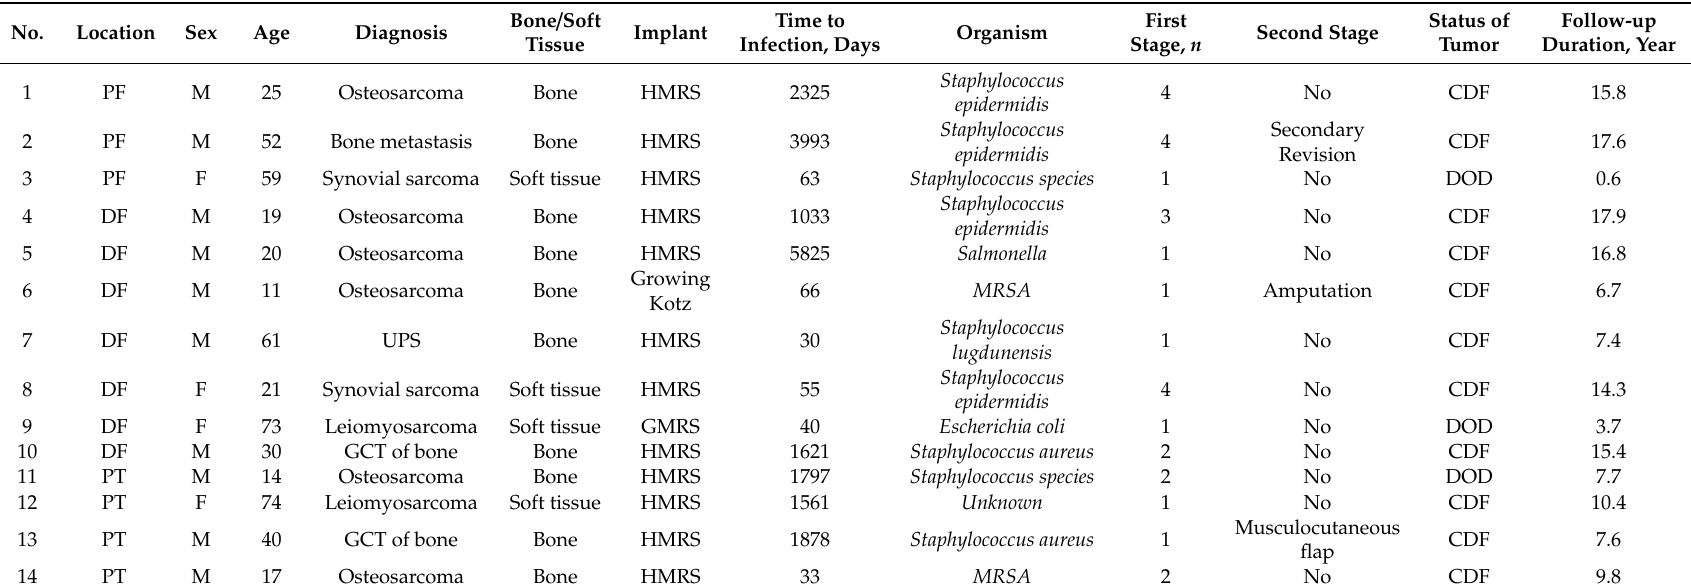
Table 2. Demographics of patients with periprosthetic